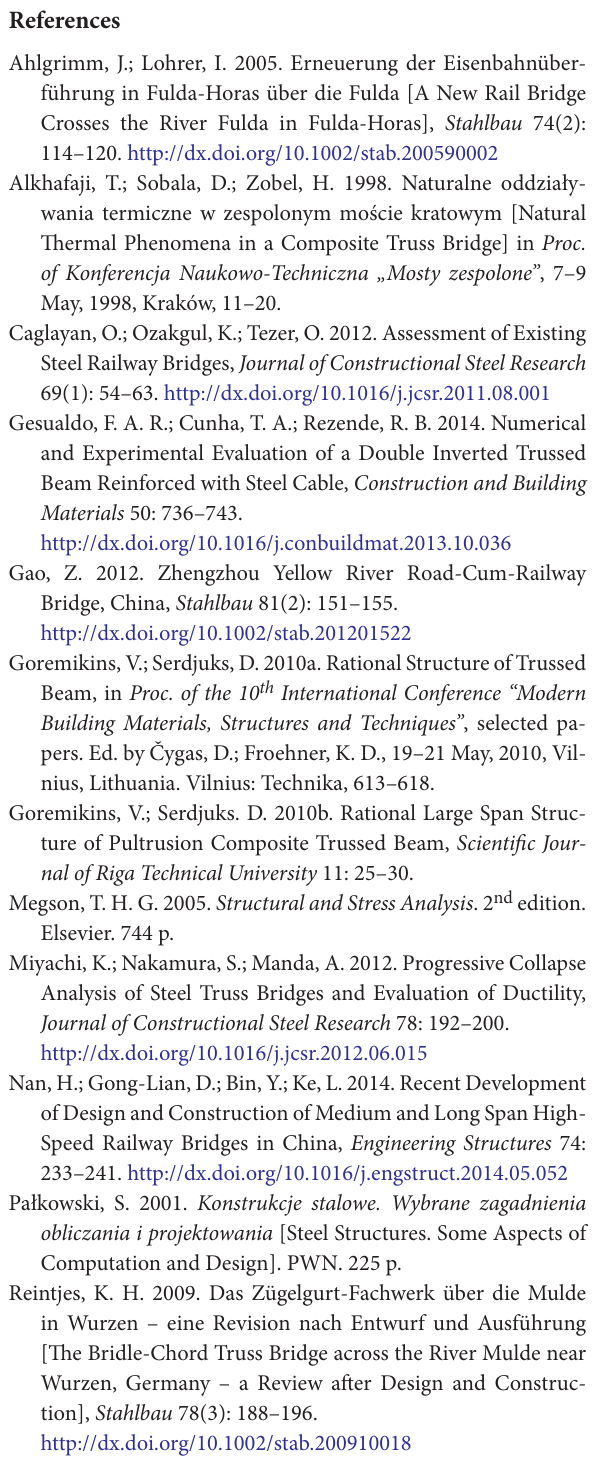
model analysis, are 0.94÷1.09 of respective results obtai- ned from the “T” model analysis. The values of vertical displacements of rigid flange nodes, obtained from “F” model analysis, are 1.05 of respective results obtained from the “T” model analysis.